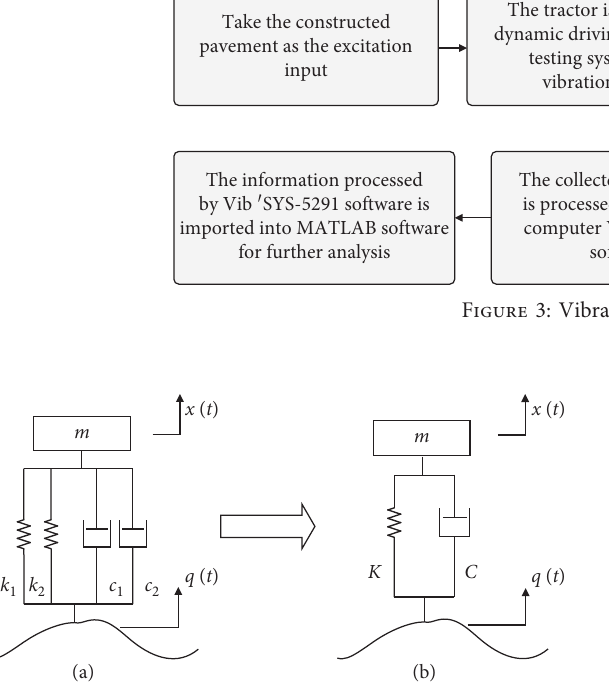
Figure 4: Simplified schematic diagram of the vehicle-ground system model. k 1 : soil vertical stiffness; k 2 : tire vertical stiffness; c 1 : soil vertical damping; c 2 : tire vertical damping; x ( t ) : wheel up and down displacement; q ( t ) : effective ground displacement input; K : system vertical equivalent stiffness sum; C : system vertical equivalent damping